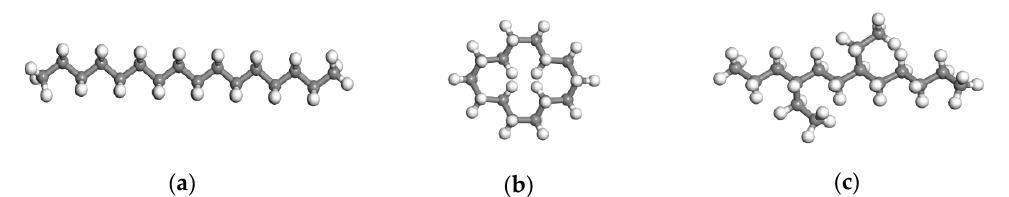
Figure 1. The all-atomic model of three molecules in the lubricant: ( a ) N-hexadecane molecule; ( b ) cyclotetradecane; ( c ) 4,7-diethyldodecane.